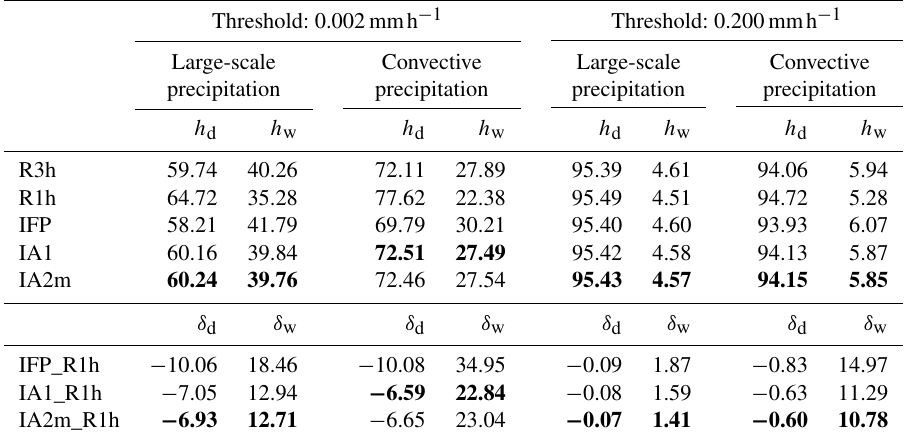
Table 5. Frequencies of dry ( h d ) and wet ( h w ) intervals in the reference (R3h, R1h) and interpolated (IFP, IA1, IA2m) precipitation data (upper part), based on the global data set for the year 2014. Relative deviations ( δ d and δ w ) between the three interpolations and R1h are shown in the lower part. Two different thresholds (0.2 and 0.002mmh − 1 ) were used to separate “wet” and “dry”. Large-scale and convective precipitation were analysed separately. All values are in percent. The reconstructed values that match best the true R1h data are printed in bold.